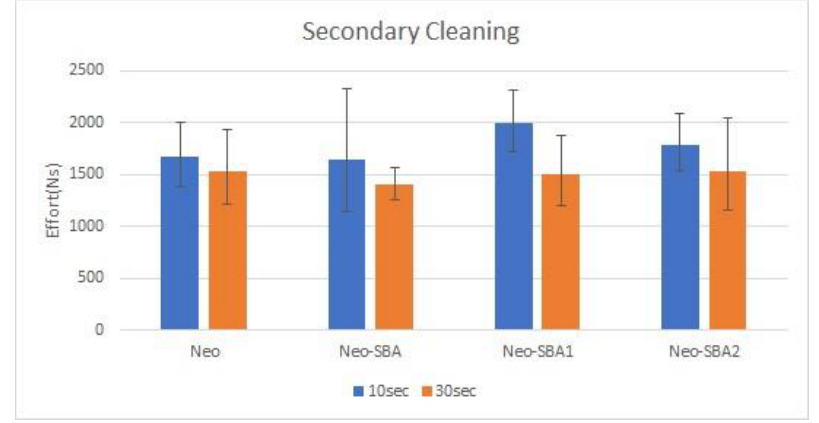
Figure 4. Total cleaning effort for secondary cleaning. The two columns for each detergent solution refer to different rinsing time (10 s and 30 s) of the substrate with water before measurements.